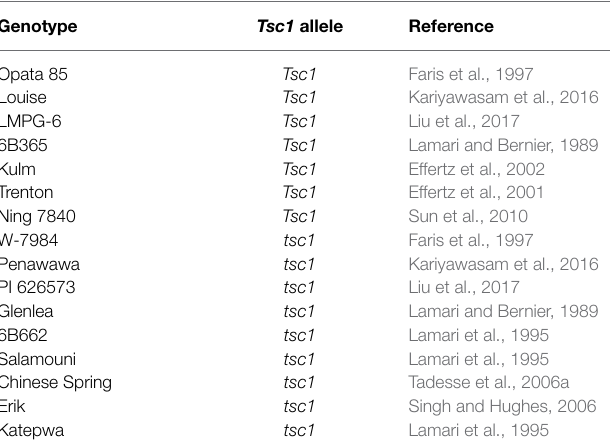
TABLE 1 | Allelic state and corresponding references of hexaploid genotypes evaluated with markers developed in this research and linked to Tsc1 . Genotype Tsc1